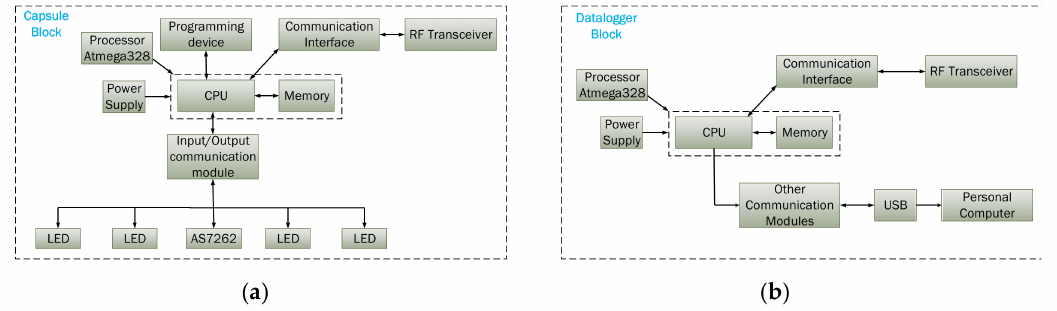
Figure 2. Hardware blocks of the proposed capsule prototype: ( a ) capsule block ( b ) data logger